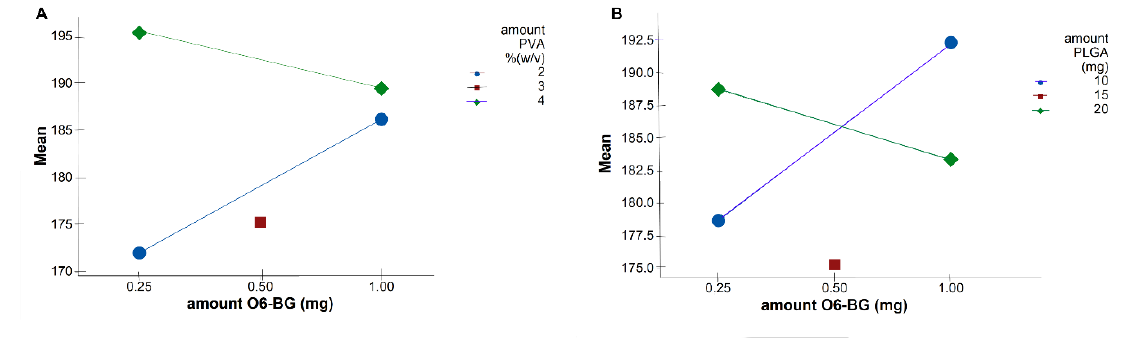
Figure 3. Interaction plots for size data means showing significant two-way interaction terms for the independent variables. Solid blue lines display factor at low level, whereas dashed green lines are the high level of the factors. ( A ) interaction term X 2 X 3 : amount of O6BG / amount of surfactant, ( B ) X 2 X 5 : amount of O6BG / amount of PLGA.